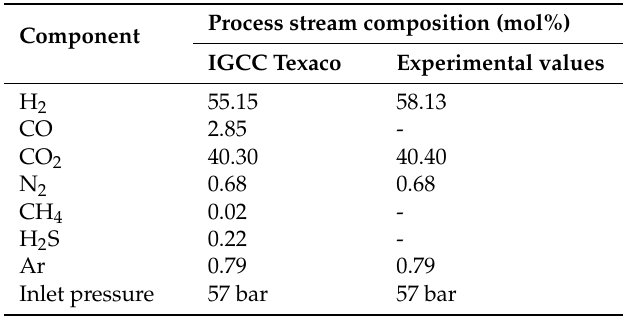
Table 1. The IGCC GE gas composition and conditions